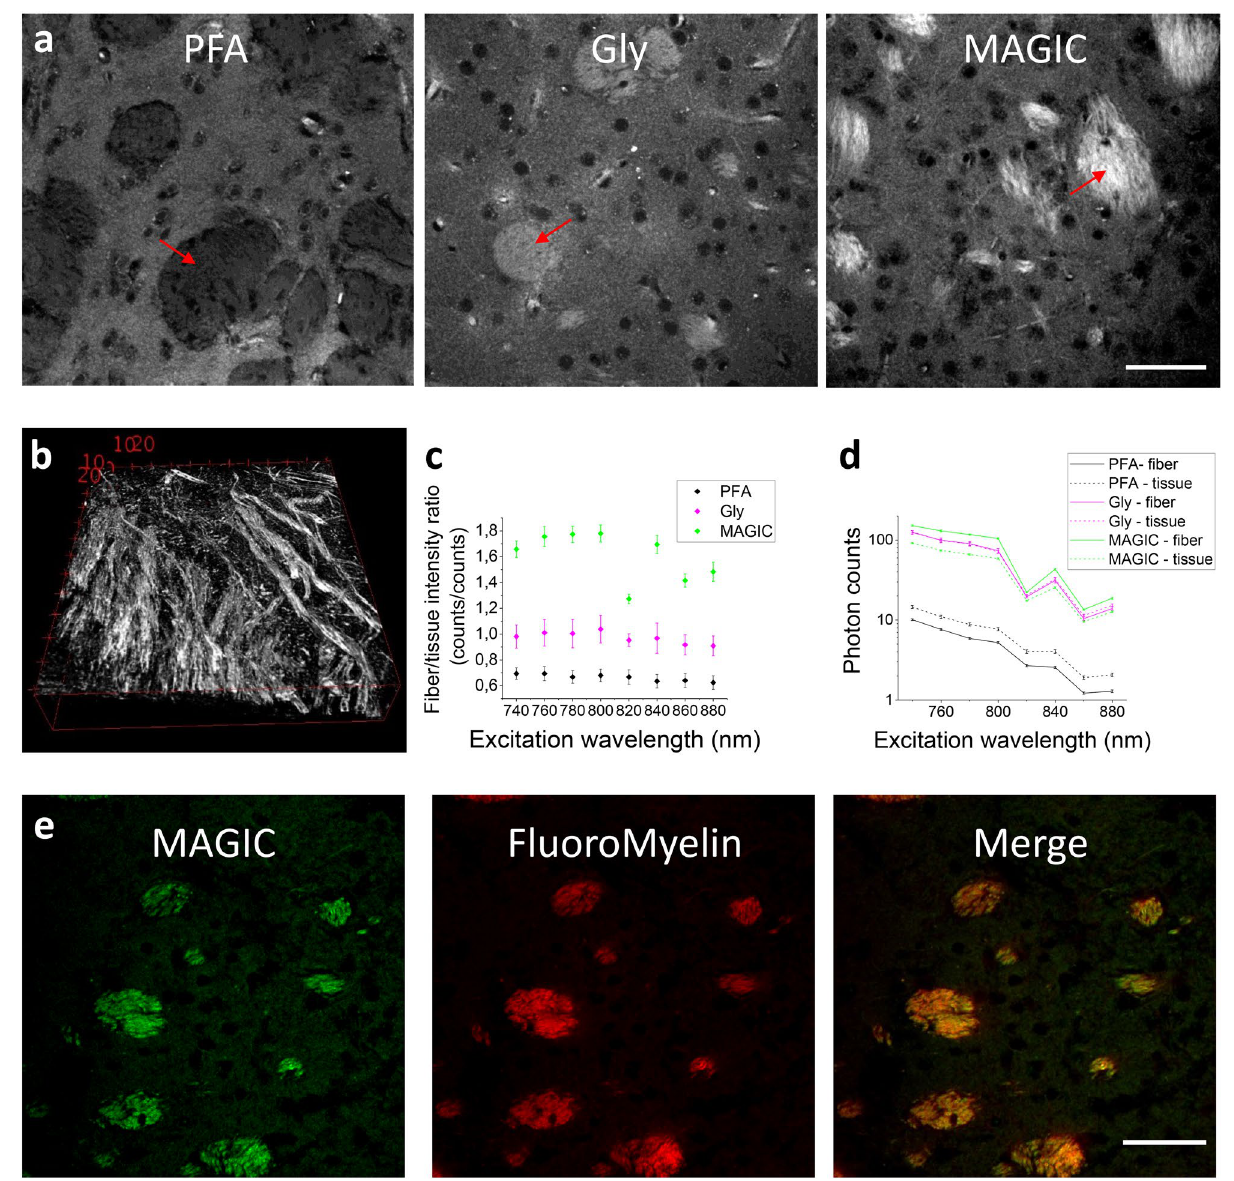
Figure 1. The MAGIC protocol. ( a ) Representative TPFM images of a mouse brain section during the three subsequent steps of the MAGIC protocol: fixation (PFA), glycerolization (Gly), and washing (MAGIC). The images show different areas of the caudate putamen. For each condition, a fiber bundle is indicated with a red arrow. Scale bar = 50 μm. ( b ) 3D reconstruction of myelinated fibers, imaging performed with TPFM at the resolution of (0.44 × 0.44 × 1) μm 3 . Box scale = 10 μm. ( c ) Measurement (mean ± std.err) of photons emitted by the myelinated fibers (fiber) and the surrounding tissue (tissue) during the different steps of the protocol (PFA, Gly, MAGIC) detected at different excitation wavelengths. ( d ) Intensity contrast (mean ± std. err) observed at different excitation wavelengths during the three steps of the MAGIC protocol. (e) Images of a mouse brain section treated with MAGIC and labeled with FluoroMyelin red. In green and red respectively, the autofluorescence and the exogenous signals are shown. Images were obtained with TPFM, scale bar = 50 μm. Images and the 3D rendering were prepared using Fiji (www. fiji. sc/ Fiji) 20 , graphs were prepared using OriginPro 9.0 (www. origi nlab.